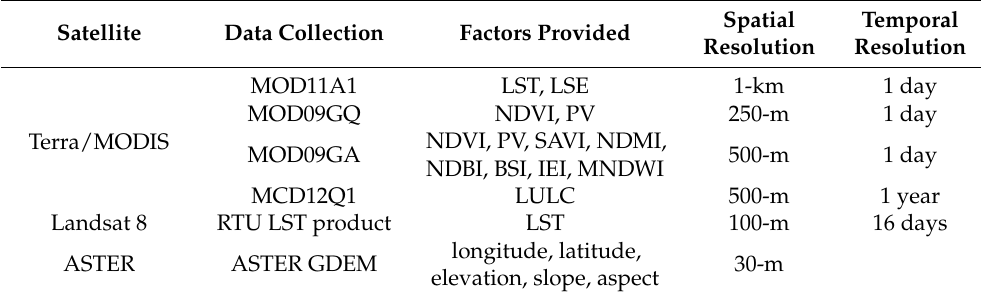
Table 1. The used data set and their main information. Satellite Data